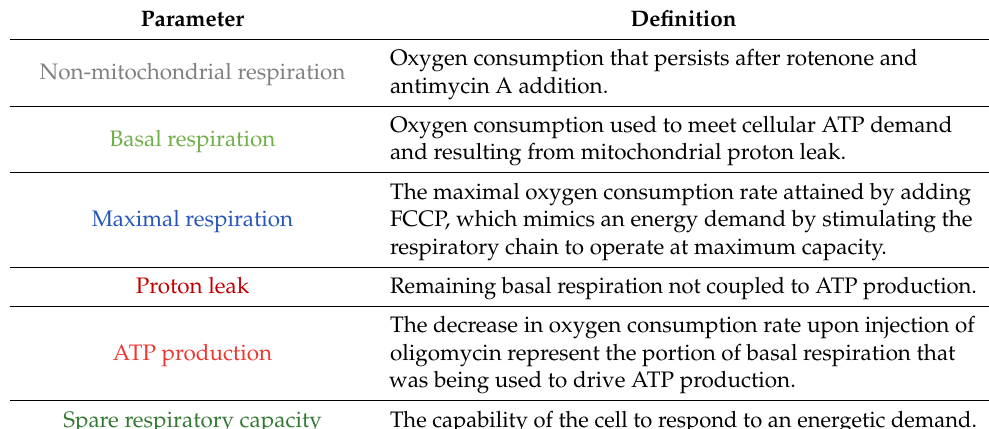
Table 4. Definition of the parameters analyzed in the Cell Mito Stress